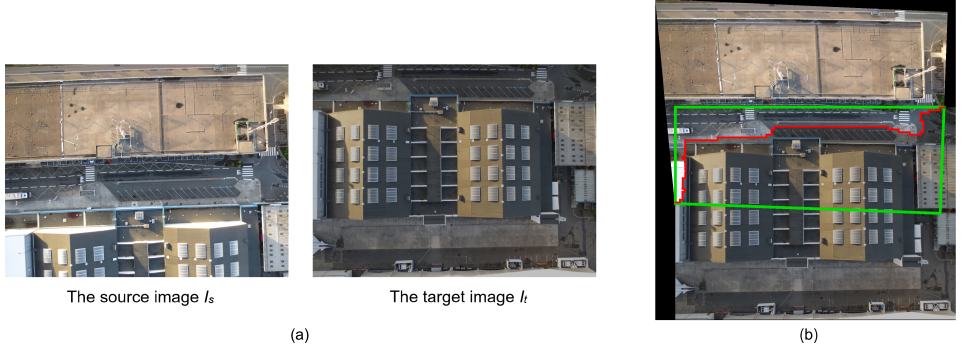
Figure 1. One stitching line example obtained by the method of Yuan et al. [10]. ( a ) The input source image I s and the target image I t . ( b ) The stitching line is marked in red and the overlapping area of I s and I t is surrounded by a green quadrilateral.